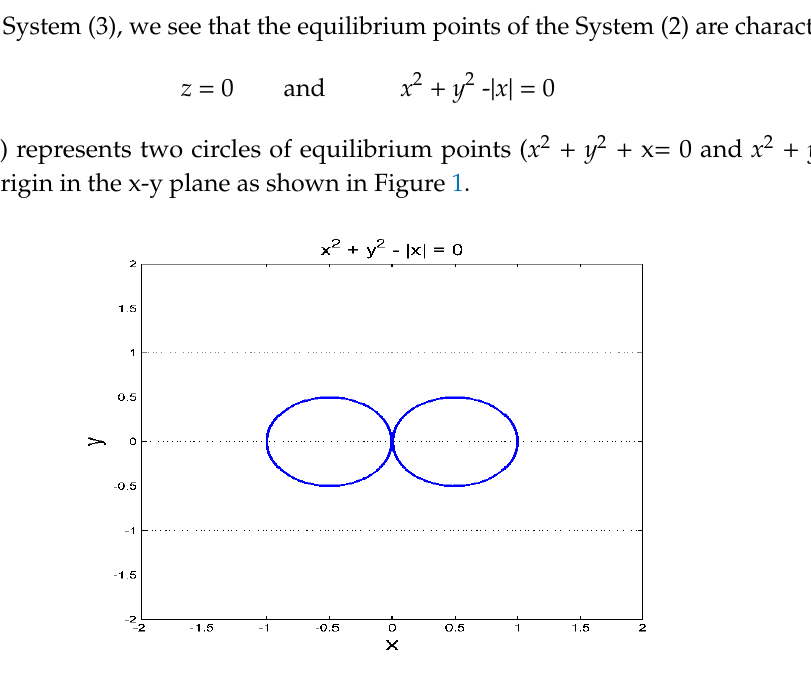
Figure 1. Two circles of equilibrium points of the new System (2) in the x-y plane. By fixing ( a , b , c ) = (4, 4.5, 1) and X (0) = (0.01, 0.02, 0.01), we numerically solve System (2) via the fourth order Runge-Kutta method. MATLAB plots depicting the chaotic attractor of the new System (2) are shown in Figure 2a–c.